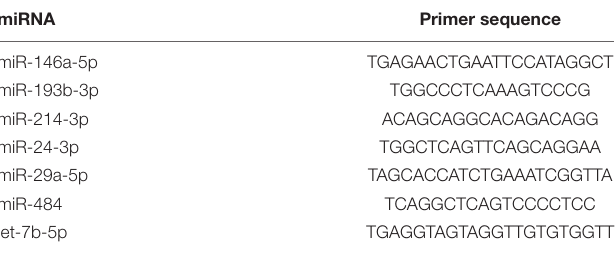
TABLE 2 | Primers used in qRT-PCR to evaluate miRNA